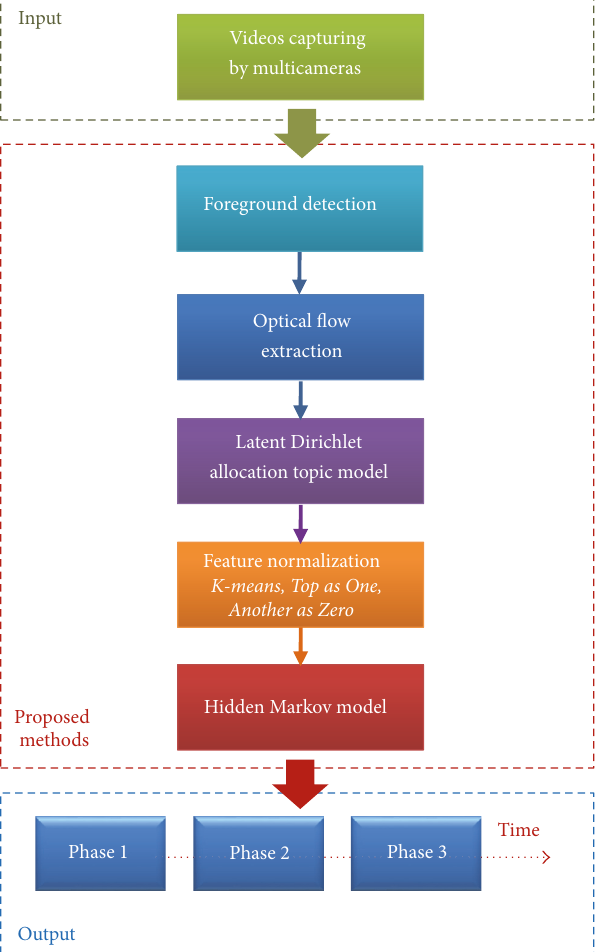
Table 1: Foreground detection methods.